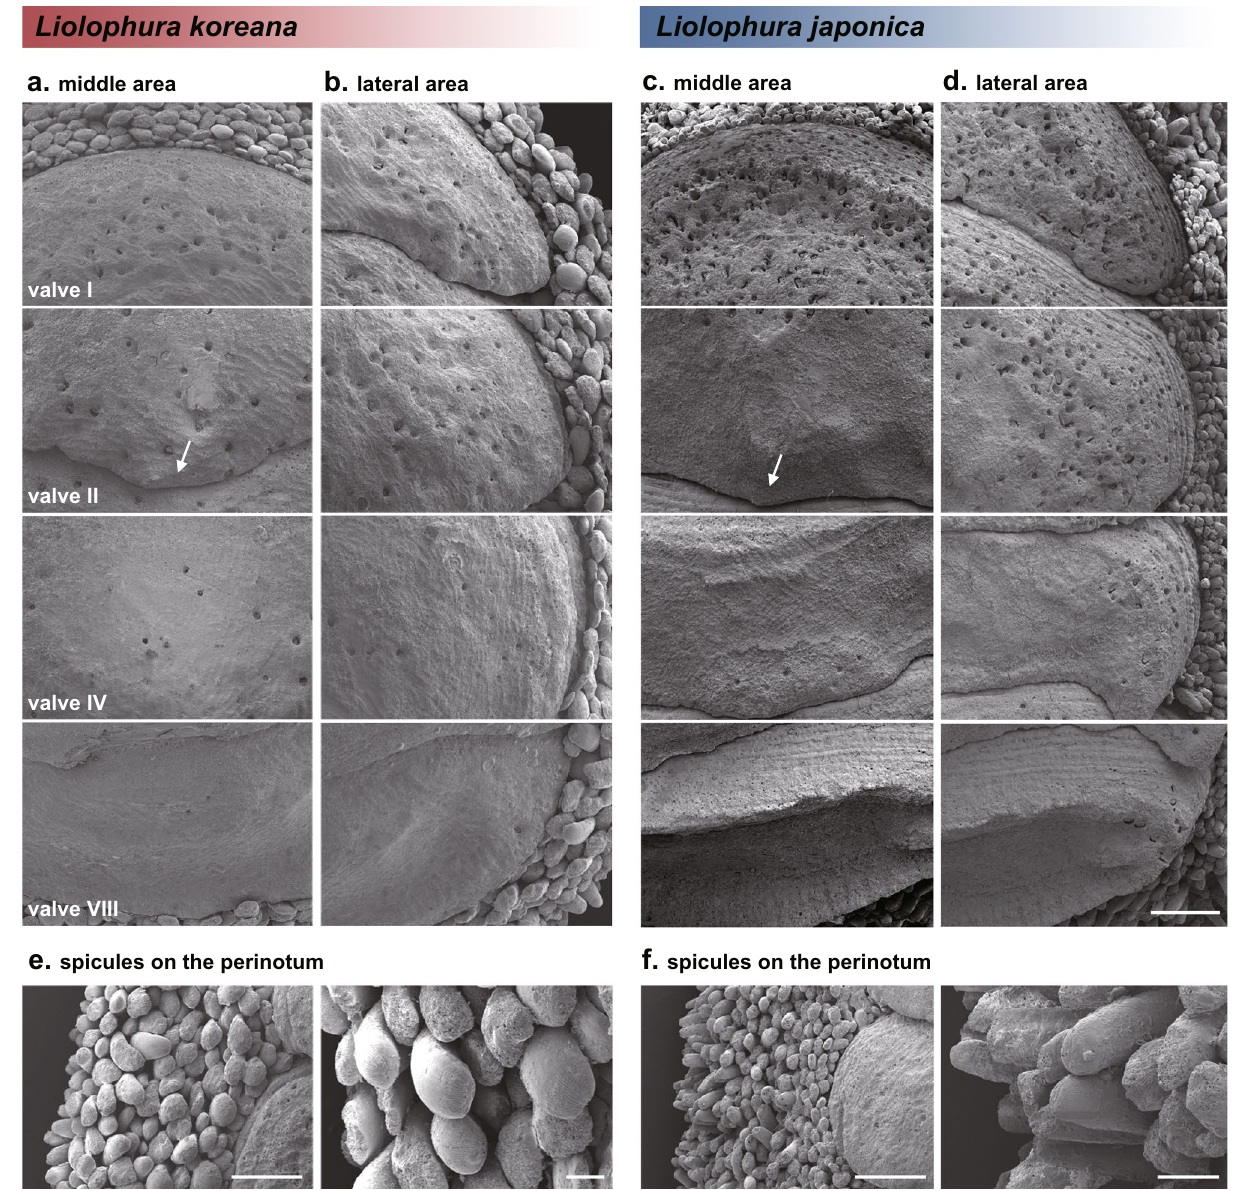
Figure 6. Microstructural comparison of Liolophura koreana , sp. nov. and L. japonica using field emission scanning electron microscopy (FE-SEM). (a,b) Middle and lateral areas on the tegmentum of the holotype of L . koreana . (c,d) Middle and lateral areas on the tegmentum of L . japonica . Arrows indicate that morphological difference of the posterior valve margin of the valve II between two species. The scale bar marks 1.0 mm. (e,f) The occurrence frequency, and shape and structure differences of the spicules on the perinotum between the holotype of L . koreana ( e ) and L . japonica ( f ). The scale bar marks 1.0 mm and 0.2 mm, respectively. The photos were edited using Adobe Photoshop v.22.2 (https:// www. adobe.